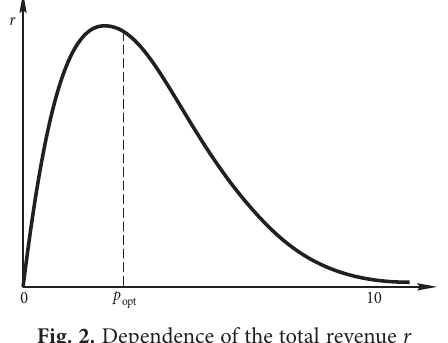
Fig. 2. Dependence of the total revenue r on the price p of 1